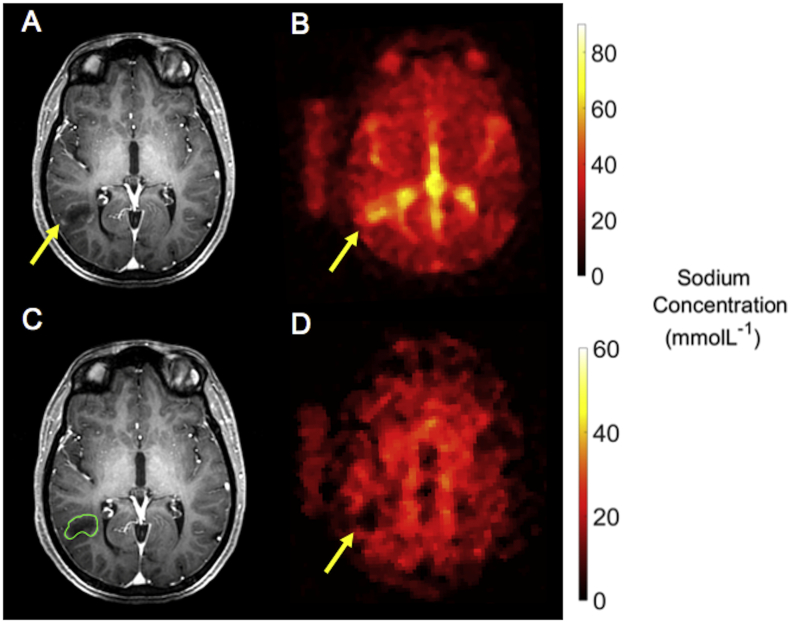
1H and 23Na images of the MS lesion and quantitative sodium analysis of the MS brain.A) Post contrast-enhanced T1-weighted image; B) Total sodium map; C) ROI placement on enhancing lesion; D) Intracellular weighted (fluid suppressed) sodium map. Arrow denotes active MS lesion.